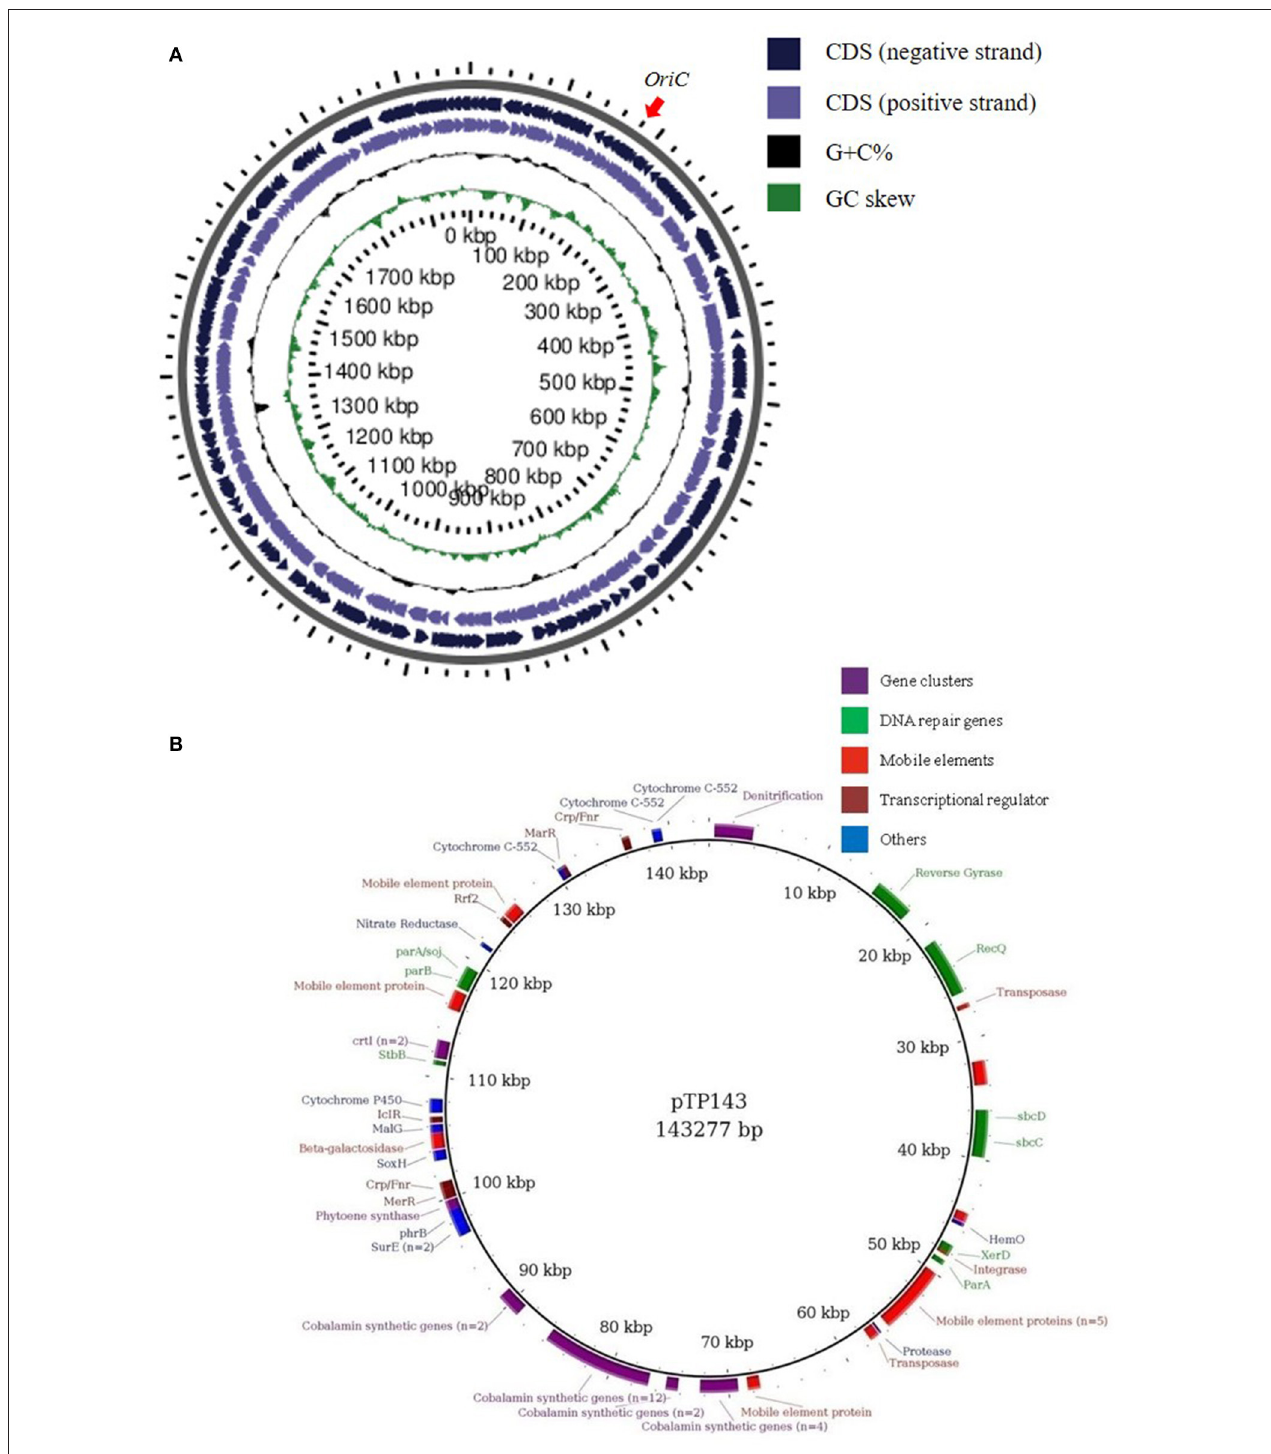
FIGURE 1 | Replicon maps of Thermus parvatiensis strain RL (A) ORFs on the chromosome have been mapped on both strands, the origin of replication is marked with a red arrow. From outside to inside: genes on the negative strand, genes on the positive strand, GC percentage and GC skew. (B) Detailed map of T. parvatiensis megaplasmid pTP143 marked with prominent categories of genes in different colors. Genes representing DNA repair genes (green), mobile element genes (red), transcriptional regulators (magenta) and gene clusters (purple; denitrification gene cluster, cobalamin biosynthetic gene cluster, carotenoid synthesis gene cluster) have been specifically